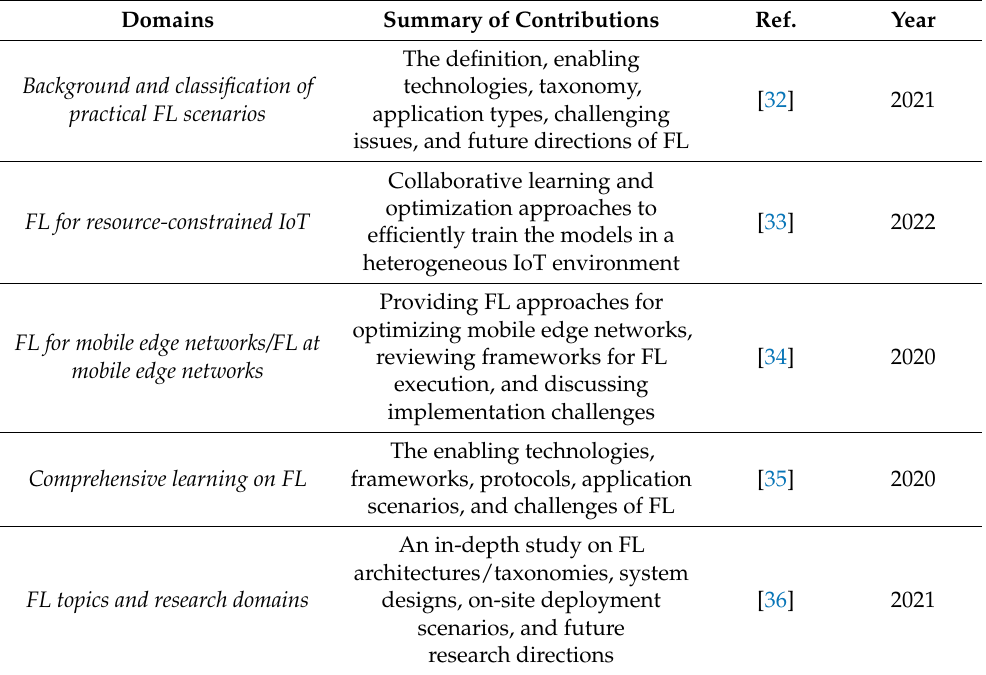
Table 2. Contributions of Existing Selected Surveys on Federated